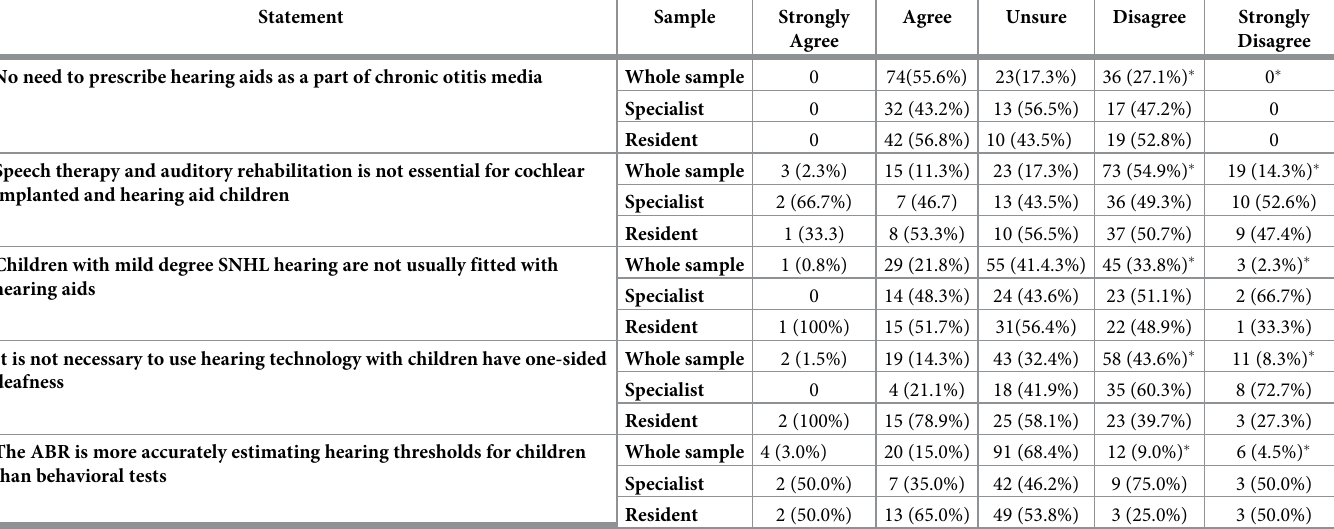
Table 5. The knowledge of 133 family physicians about hearing loss